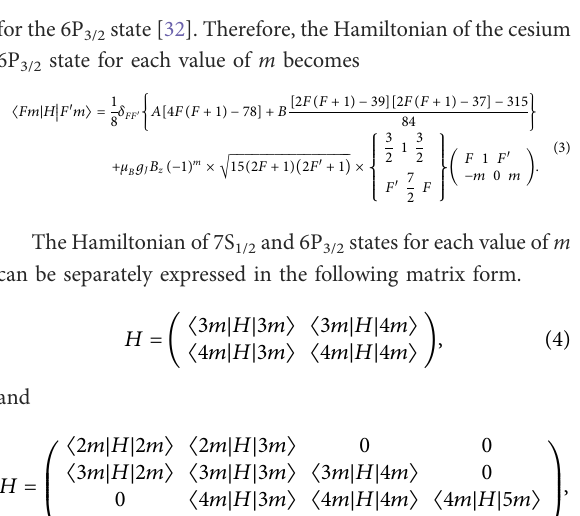
FIGURE 2 Splitting of the energy levels as a function of magnetic- fi eld strength for the 7S 1/2 upper level and the 6P 3/2 lower level of clock transition.TheblueandblacklinesrepresenttheZeemansublevels of 7S 1/2 F = 4 and F = 3. The red, green, purple, and gray lines are the Zeeman sublevels of 6P 3/2 F = 5, F = 4, F = 3, and F = 2.